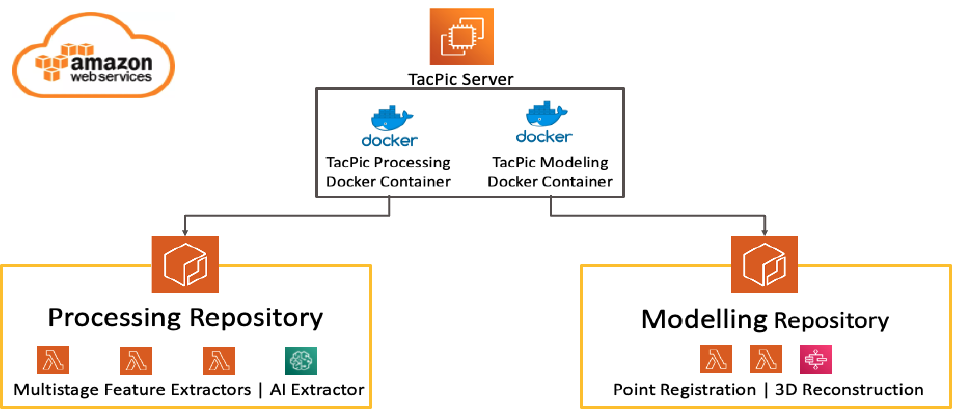
Figure 3. The processes implemented though cloud computing using the AWS functions.